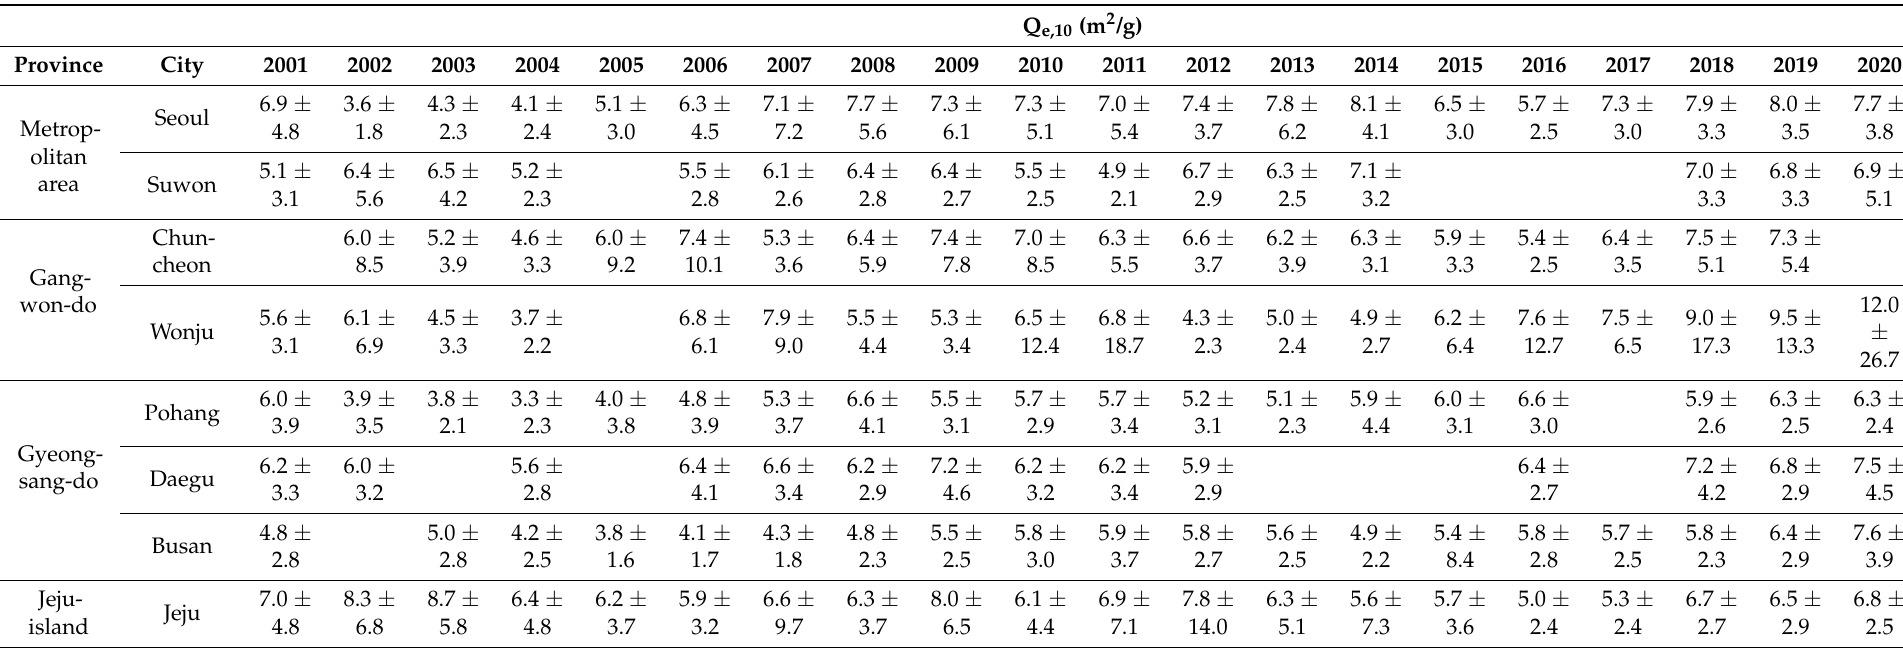
Table 5. Q e,10 by city from 2001 to 2020.